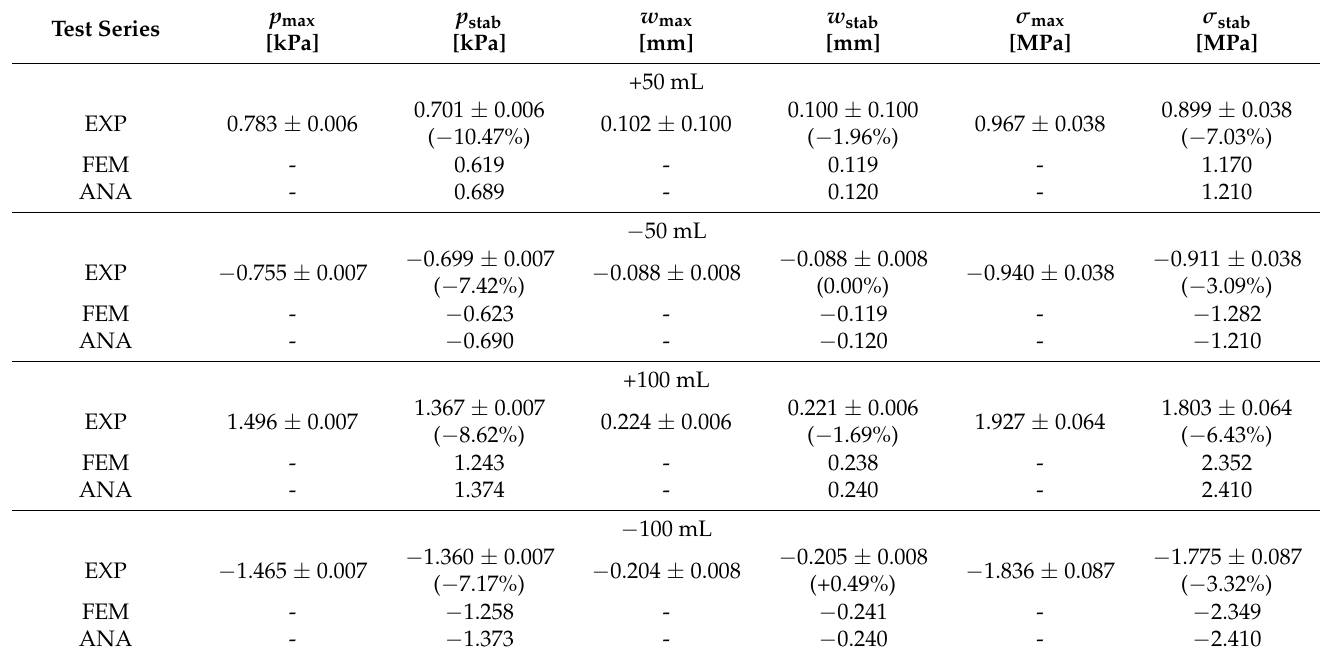
Table 3. Results of experimental research, numerical and analytical